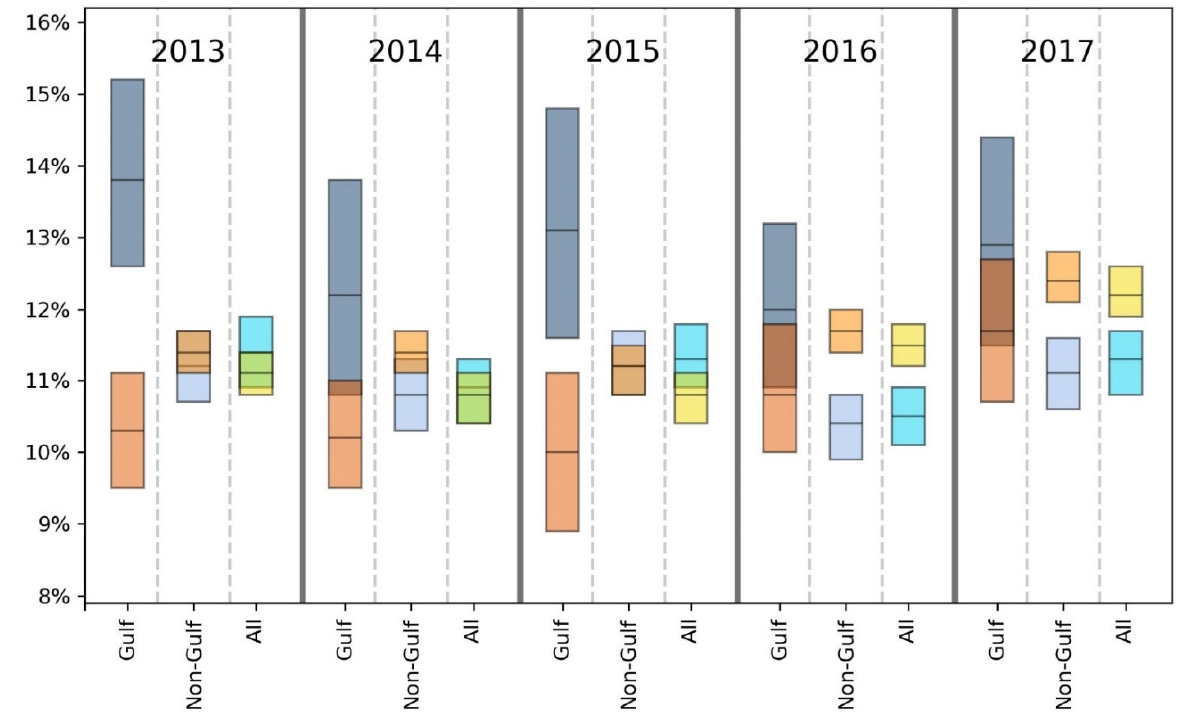
Figure 5. Comparison of mean (black line across bar) and 95% confidence intervals for percentages of Gulf and non-Gulf MMSA respondents reporting ≥ 14 mentally unhealthy days out of the last 30. Colors denote the following: dark blue = coastal Gulf, light blue = coastal non-Gulf, dark orange = non-coastal Gulf, light orange = non-coastal non-Gulf, bright blue = all coastal, yellow = all non-coastal.